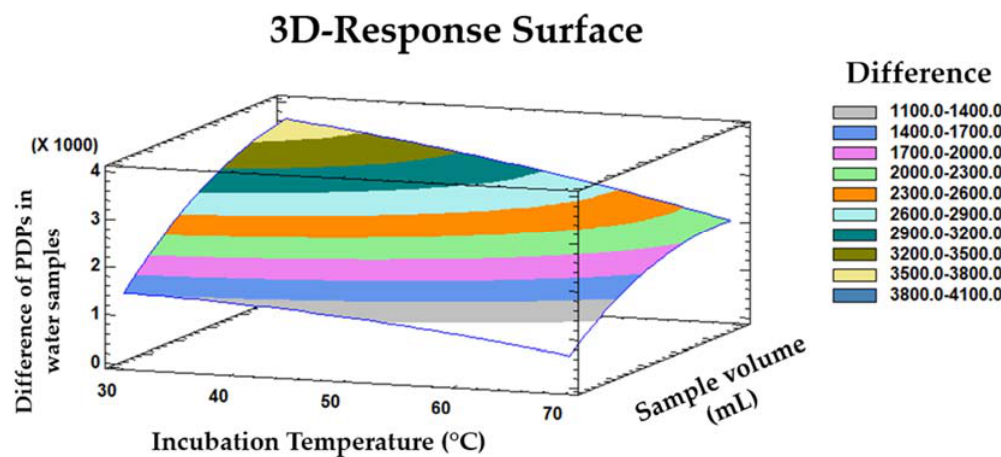
Figure 3. 3D-surface plot representing the influence of incubation temperature and sample volume on the differences among the ion mobility spectrometry (IMS) intensities between PDPs in water.